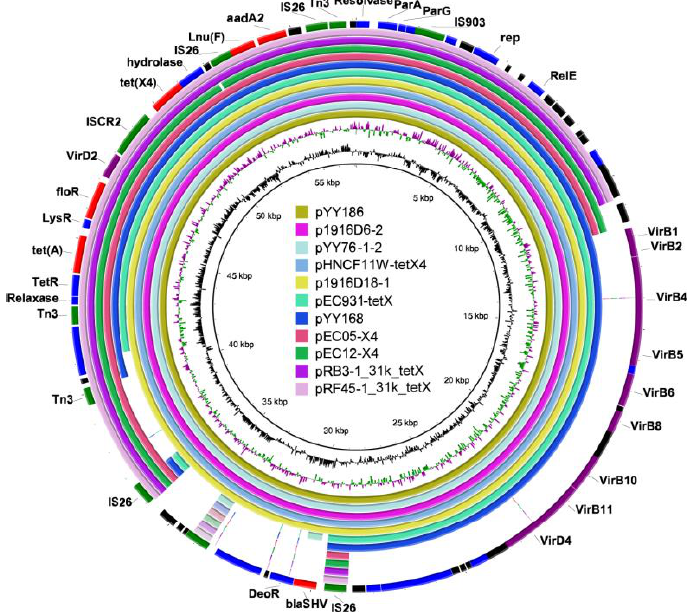
Figure 4. Circular comparison of the tet (X4)-bearing IncX1 plasmids with other closely related IncX1 plasmids from the NCBI database. The outermost ring represents the reference IncX1 plasmid pYY186 with its gene positions. Different colors in the outermost ring represent distinct genes: Red represents the resistance gene, purple represents the gene of T4SS, green represents the mobile element, black represents the hypothetical protein, and blue represents other functional genes. The map was constructed using BRIG software.